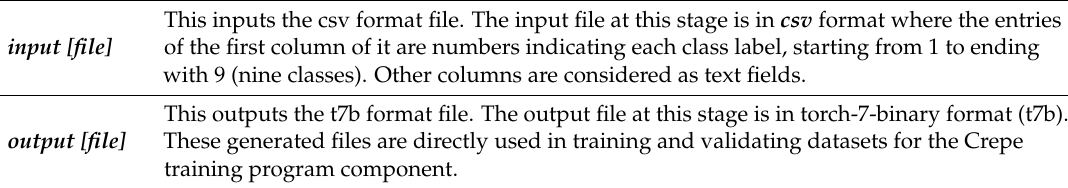
Table A1. Data preprocessing command-line